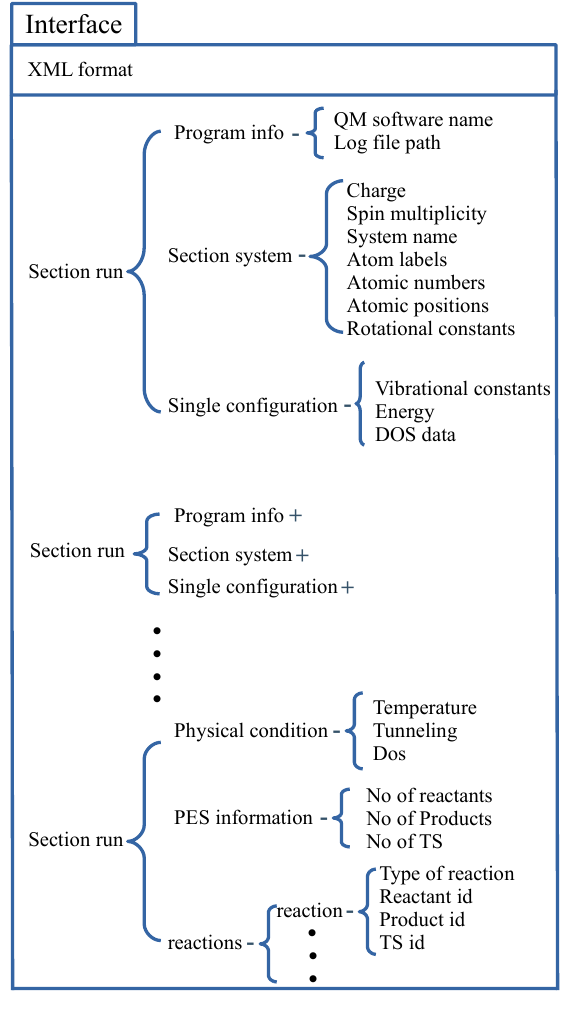
Figure 2. Hierarchical data structure of the XML interface.